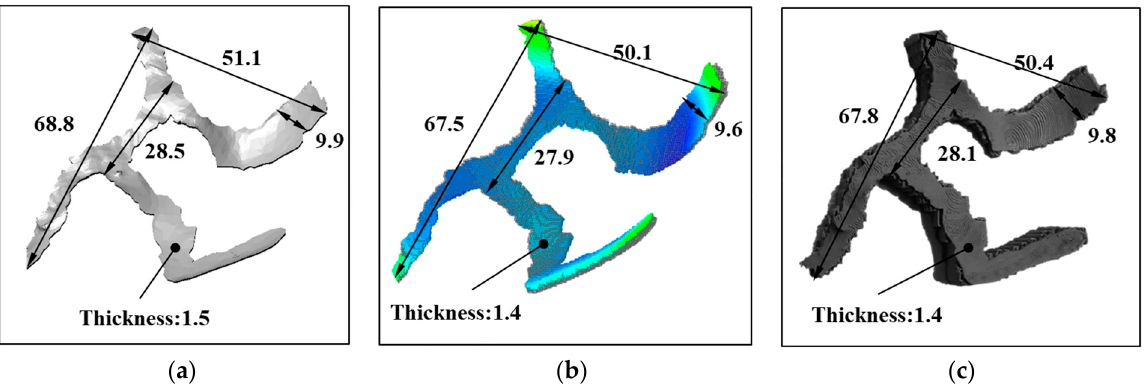
Figure 7. Typical dimensions of LH part of the customized implant. ( a ) CAD design; ( b ) simulation estimation; ( c ) printed green part.